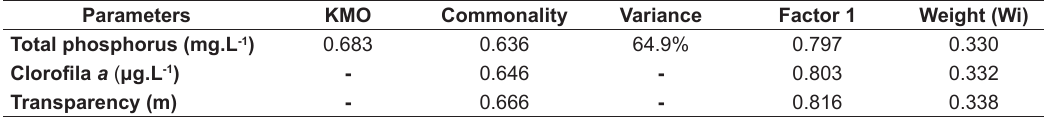
Table 1. Correlation data between the parameters selected through the SPSS software. Parameters